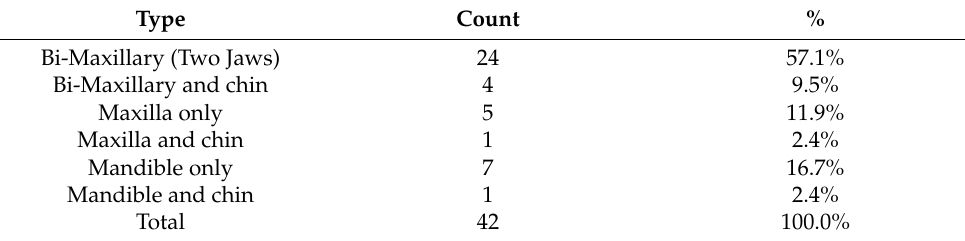
Table 3. Prevalence of different surgery